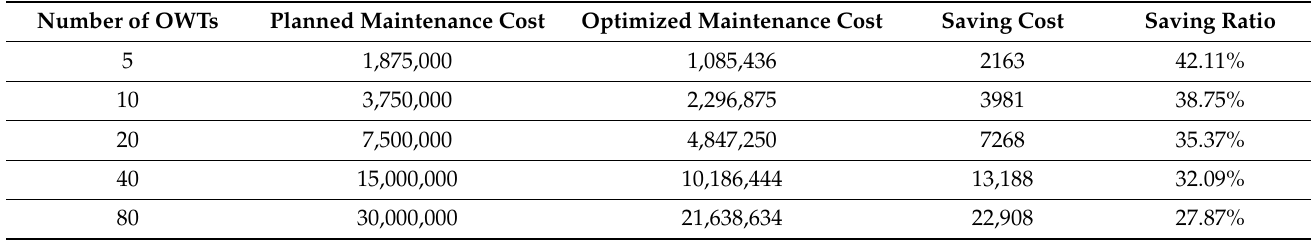
Table 7. Maintenance cost savings of offshore wind farm with different amount of OWTs. (¥/year). Number of